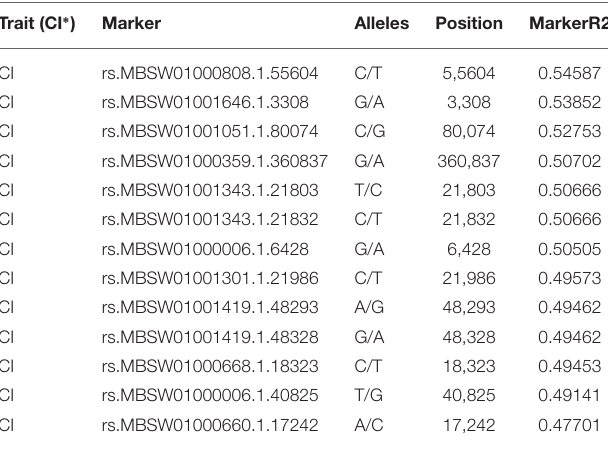
TABLE 2 | The position of significantly associated single nucleotide polymorphisms (SNPs) with virulence of Tilletia indica based on association analysis using the mixed linear model